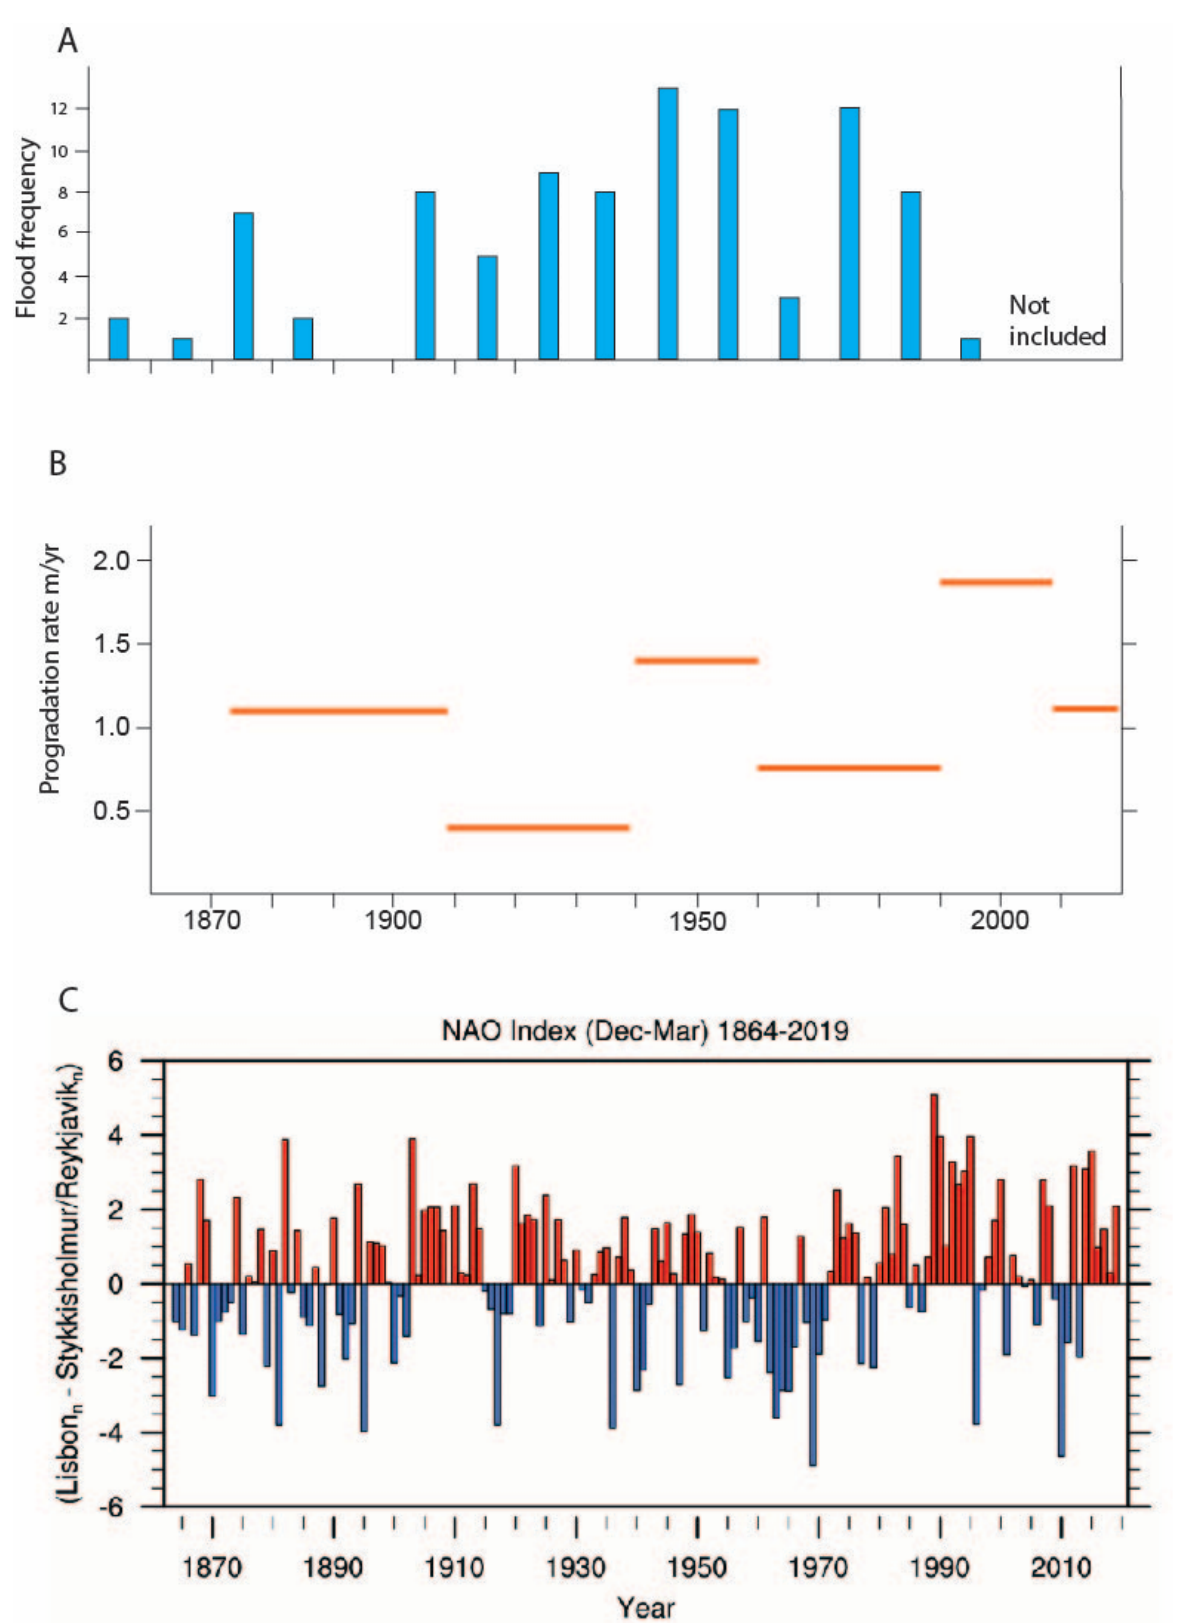
Figure 8. ( A ) Flood frequencies for southwest England since the 1780s, compiled by [34]. ( B ) Rates of progradation determined in this study. ( C ) Hurrell North Atlantic Oscillation (NAO) winter (December–March) station-based index from [35].